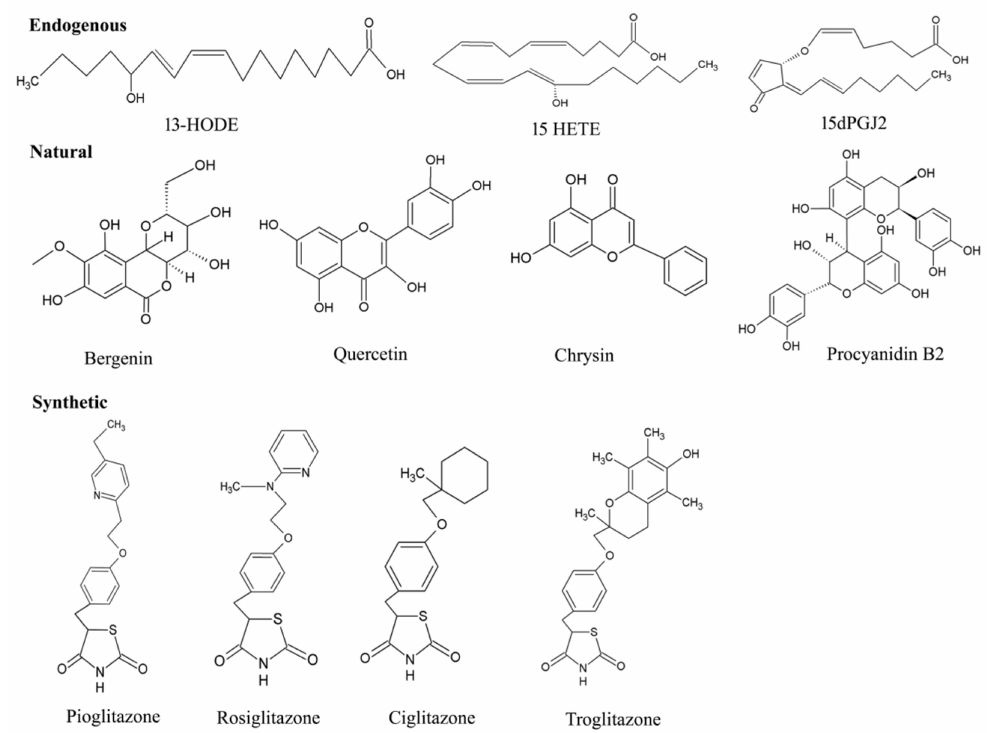
Figure 6. Chemical structures of various types PPAR- γ ligands (Endogenous, natural, and